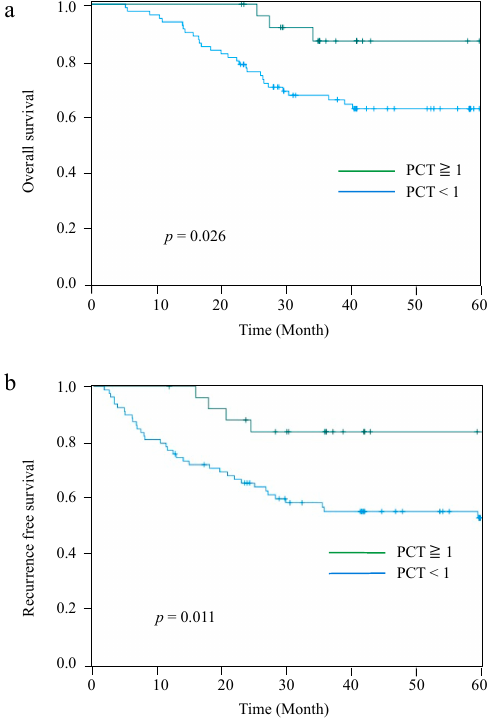
Figure 2. Kaplan–Meier curves for OS between the PCT-High group and PCT-Low group at 2 POD ( a ). RFS between the PCT-High group and PCT-Low group at 2 POD ( b ).